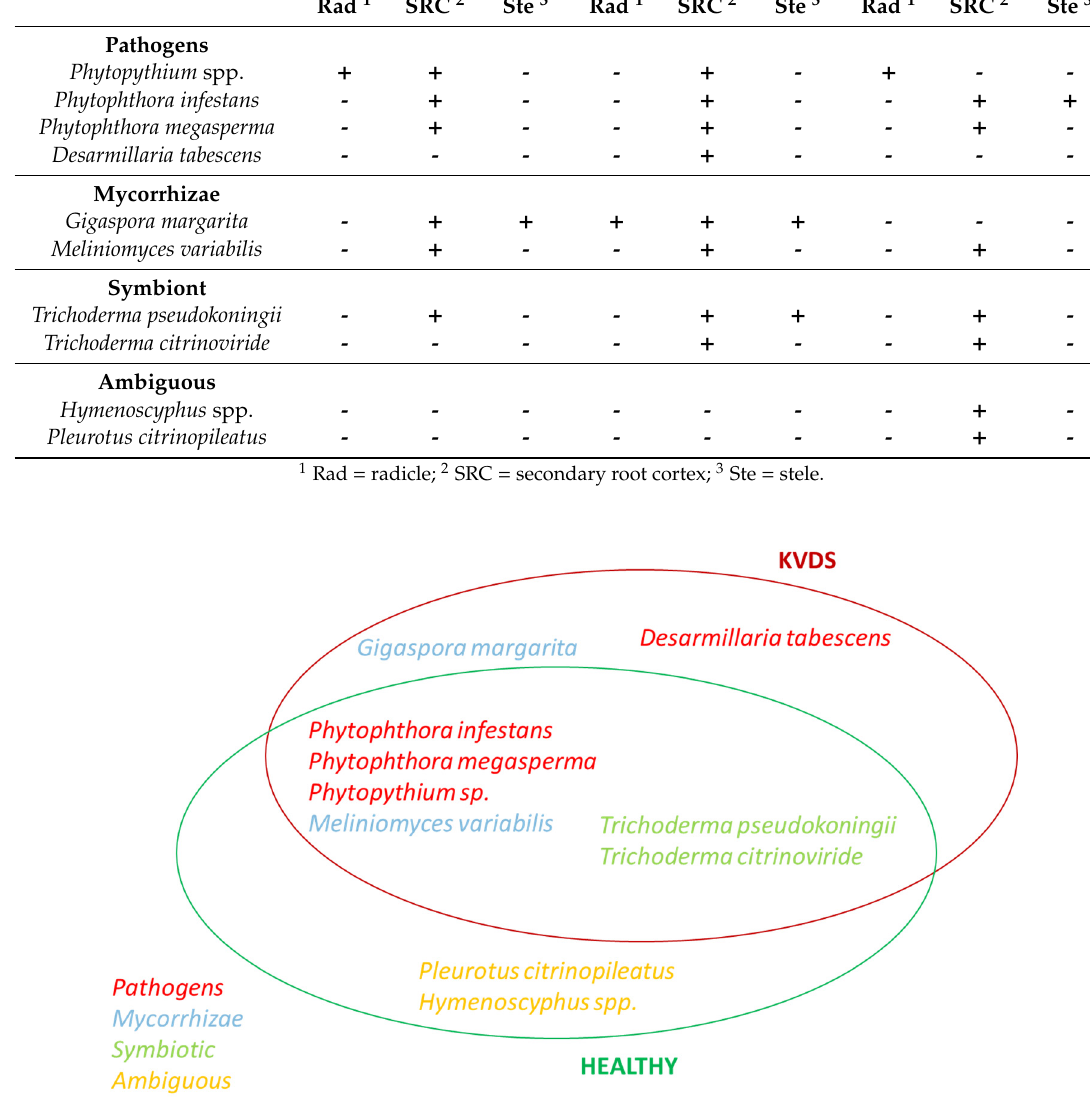
Figure 3. Venn diagram showing the unique and shared fungal isolates between healthy (green circle) and KVDS symptomatic roots (red circle).